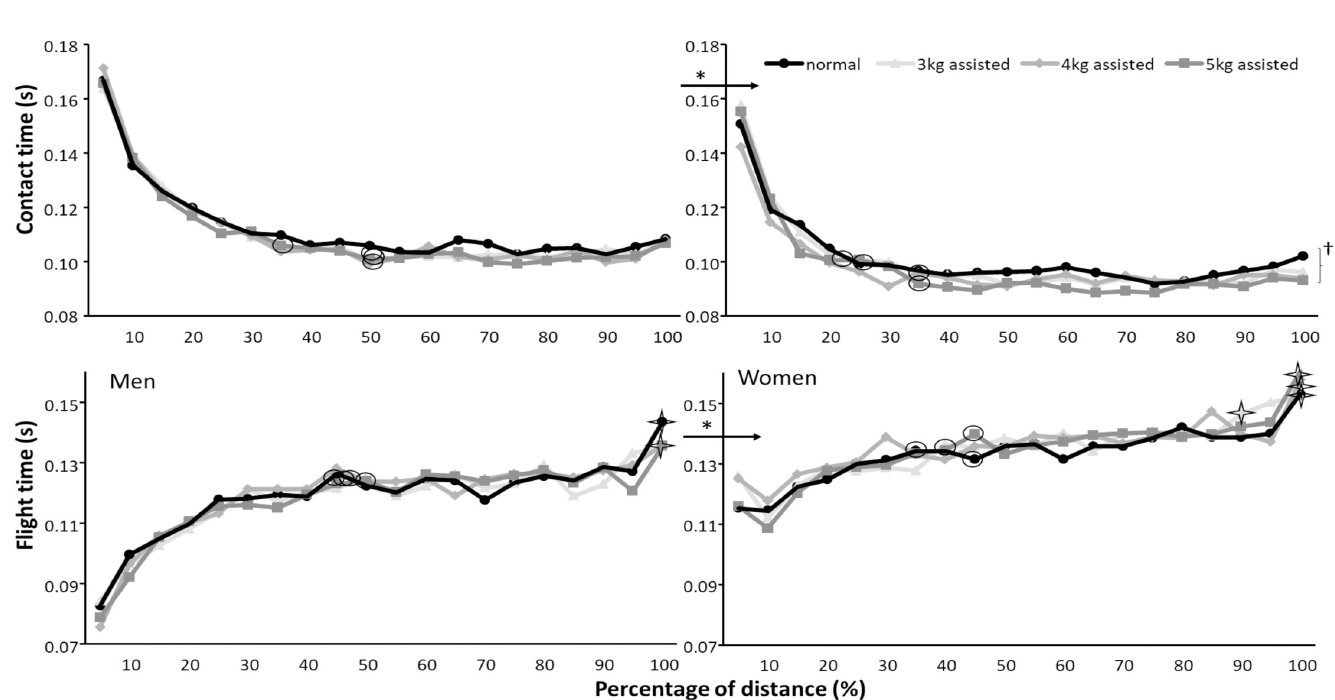
Fig 5. Average contact and flight times per 5% of the normal and 3, 4, and 5 kg assisted 60 m sprints for men and women. � indicates a significant difference between men and women for each of the sprint conditions. † indicates a significant difference between these two sprint conditions. ʘ indicates where maximal/ minimal values were reached for this condition. indicates where maximal/minimal values increased again for this condition. https://doi.org/10.1371/journal.pone.0255302.g005 PLOS ONE | https://doi.org/10.1371/journal.pone.0255302 July 27,